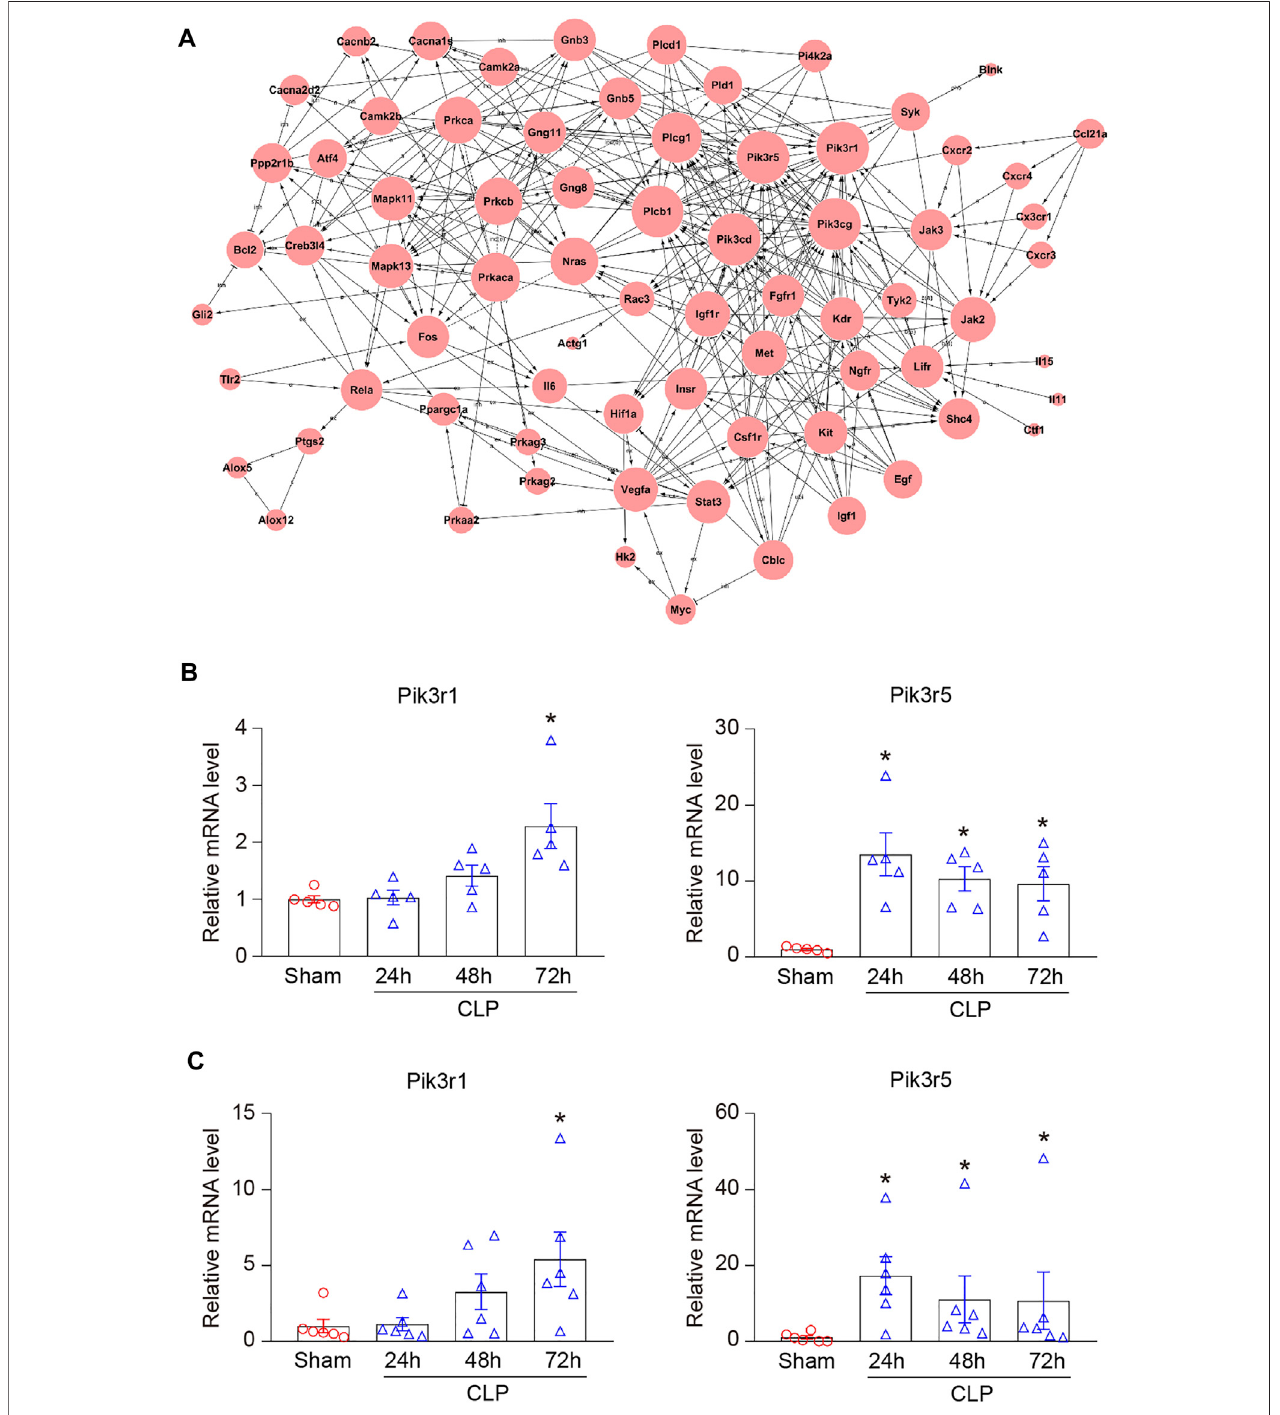
FIGURE6| Analysisofgeneco-expressionnetwork. (A) 76genesselectedfrom15signi fi cantpro fi les(No.42,29,40,48,18,7,21,45,5,12,46,4,2,17,and35) werefurtheranalyzedusinggeneco-expressionnetworkwithk-corealgorithm.Thecyclenodedepictsgenes,andtheedgebetweentwonodesindicatestheinteraction betweengenes. (B) RNAsequencinganalysisofphosphoinositide-3-kinase regulatory subunit1(Pik3r1)and Pik3r5 intheheart after CLPsurgery at24, 48,and 72 h(n = 5 per group). (C) qPCR analyses of the mRNA expression levels of Pik3r1 and Pik3r5 in septic myocardium (n = 6 per group). GAPDH as an internal control. The signi fi canceofdifferencebetweenthemeansofgroupswasevaluatedusingOne-wayANOVAfollowingNewman-Keulsmultiplecomparisontest.* p < 0.05versussham control.